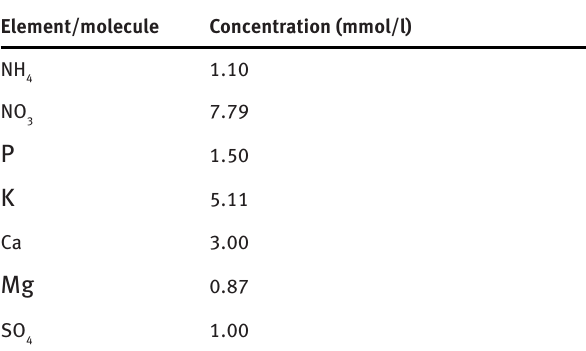
Table 2: Nutrient content of the solution applied to the growing trays. The EC was 1.45 mS/cm and the pH 5.7. The solution was made by adding 25.2 l Zwakal, 44.2 l BFK, 14.4 l Baskal, 13.8 l Amnitra, 10.4 l Magnitra and 64 l Calsal to 100,000 l of water (standard solution for pot plants at Wageningen UR)